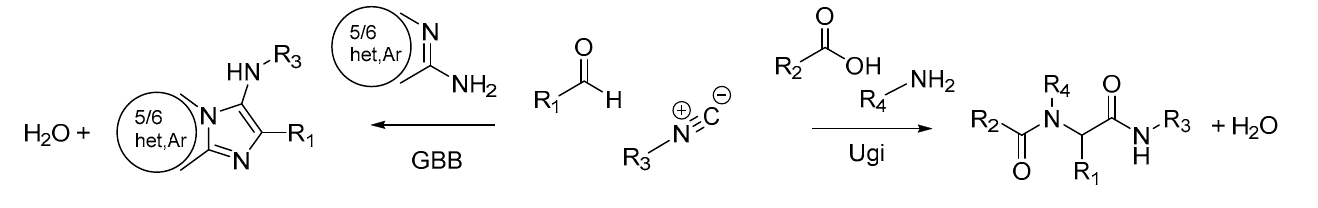
Figure 1. Ugi and GBB reactions.